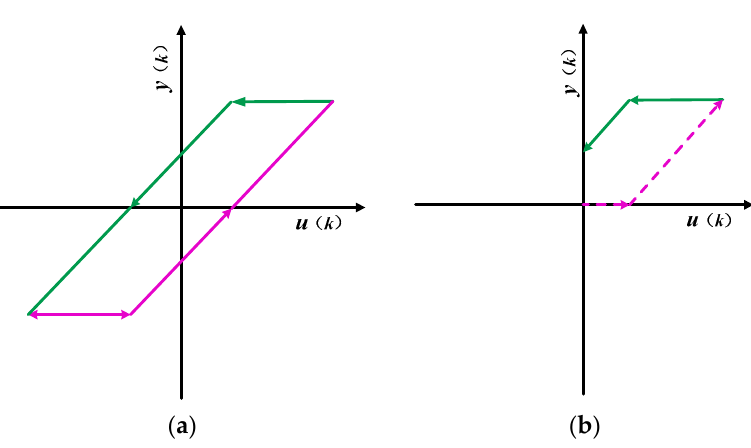
Figure 9. ( a ) Complete play operator; ( b ) play operator in practical application.